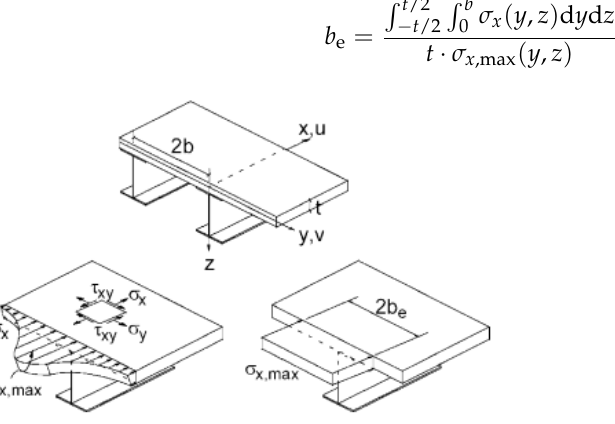
Figure 3. Concept of effective flange width [18].